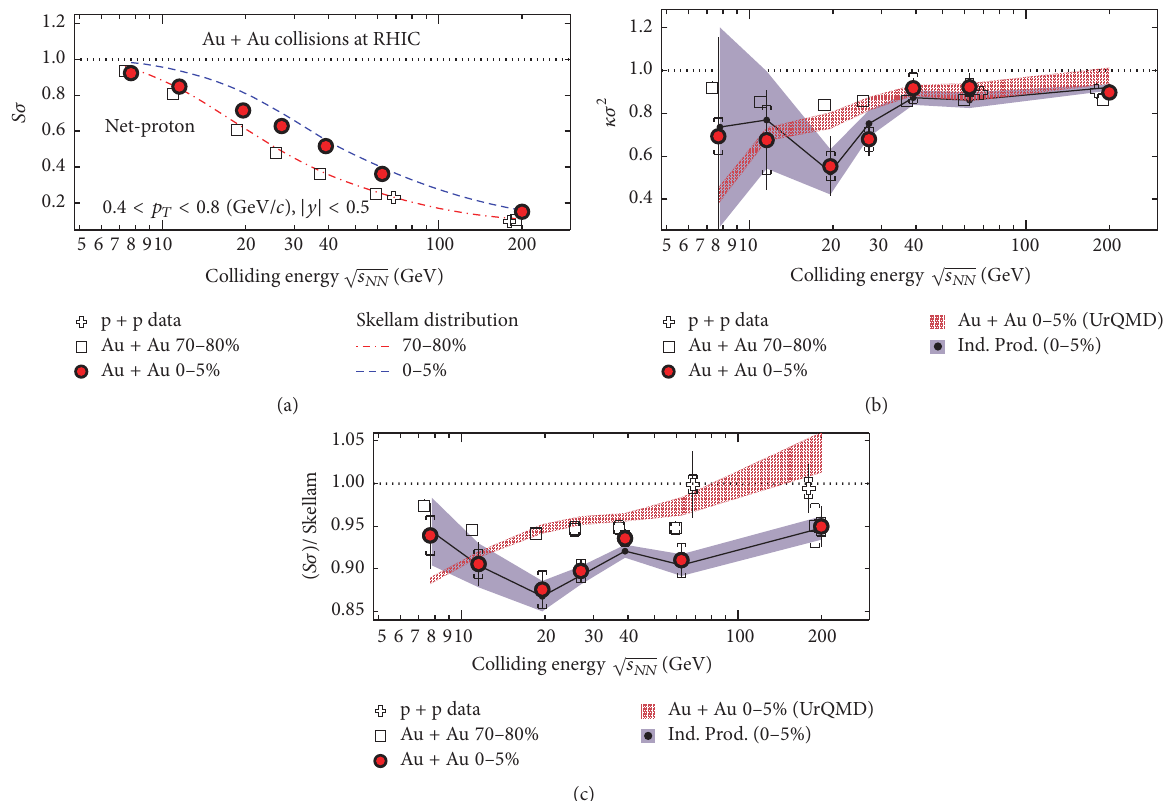
Figure 7: Collision energy and centrality dependence of efficiency corrected 𝑆𝜎 and 𝜅𝜎 2 of net-proton distributions from Au + Au and p + p collisions at RHIC [63]. Skellam distributions for corresponding collision centralities are shown for 𝑆𝜎 . Shaded hatched bands are the results from UrQMD. In (b) and (c), the shaded solid bands are the expectations assuming independent proton and antiproton production. The HRG values for 𝜅𝜎 2 and 𝑆𝜎 /Skellam are unity [68, 72]. The error bars are statistical and caps are systematic